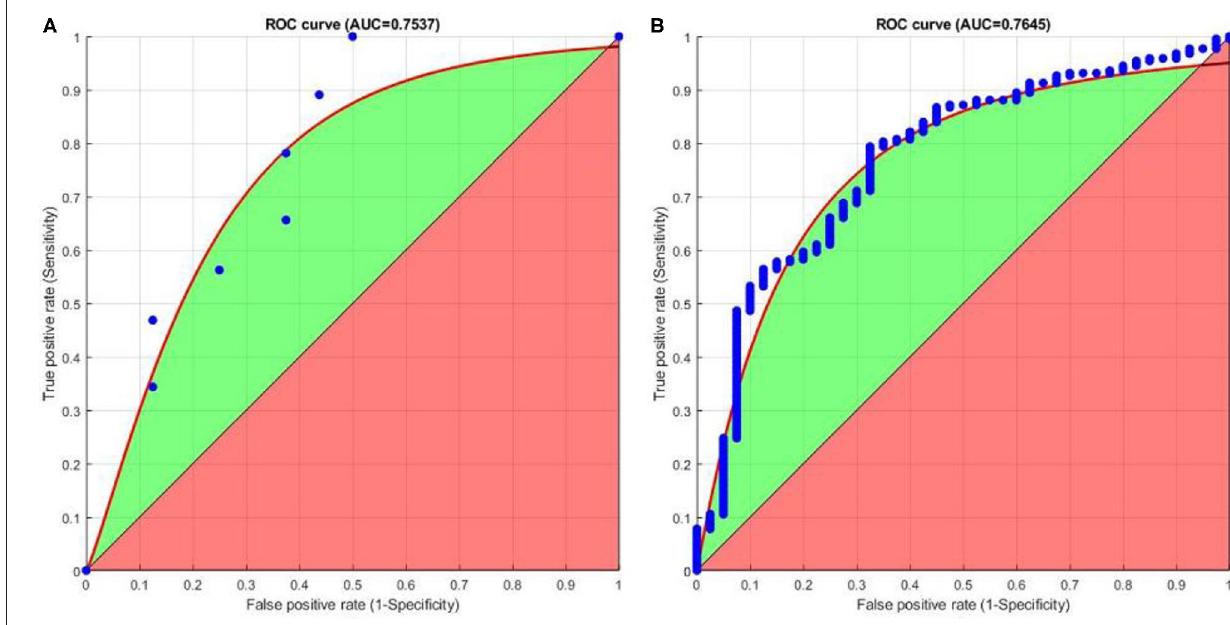
FIGURE 11 | ROC curve for (A) FVC2004 dataset. (B) NIST SD27 dataset.